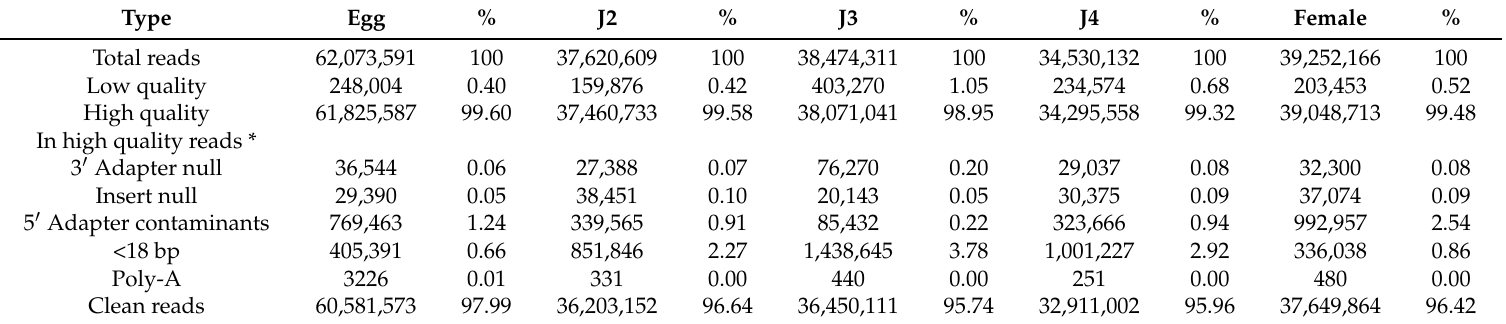
Table 1. Statistics of small RNAs obtained from high-throughput